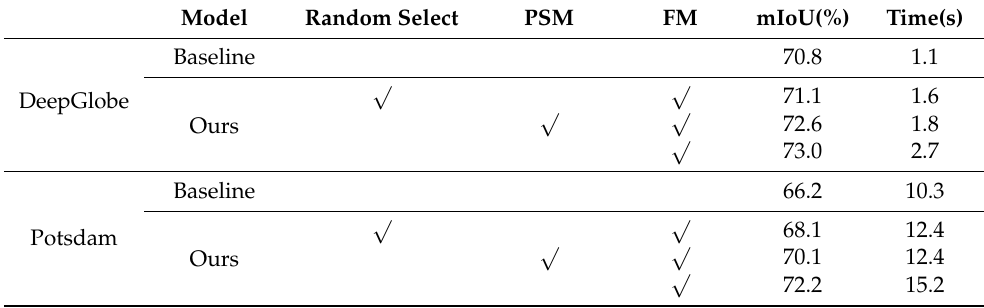
Table 6. The effects of different components of our method on the results.